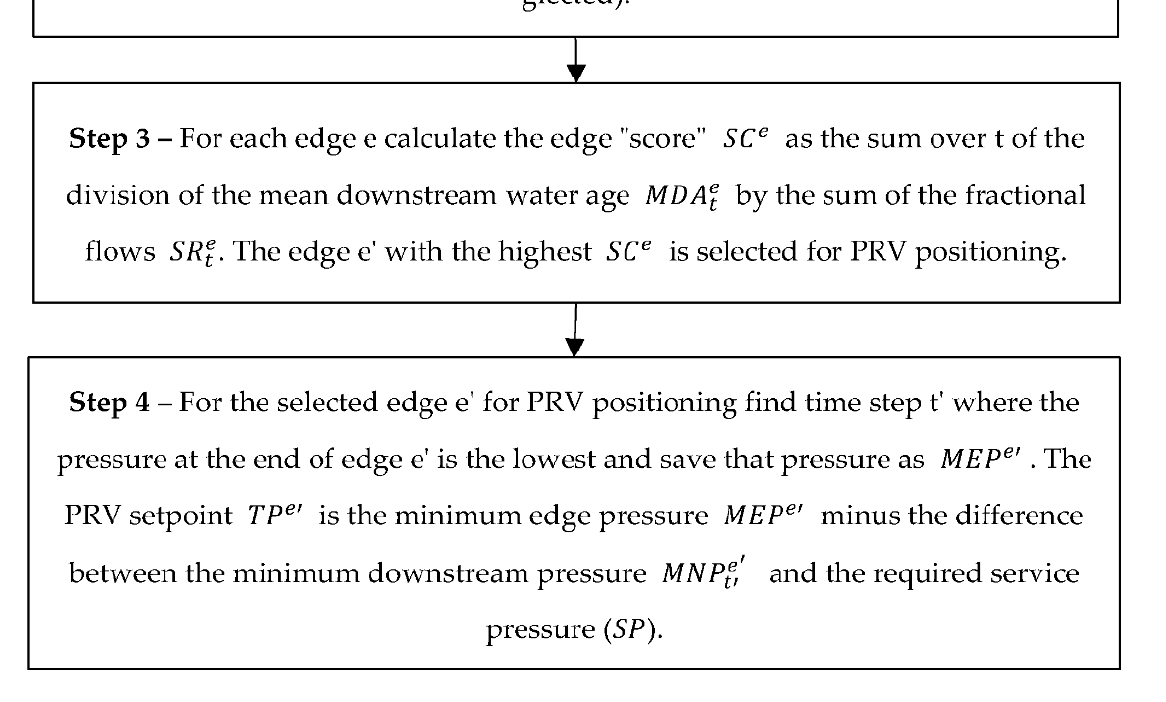
Figure 1. A flow chart describing the algorithm’s methodology.